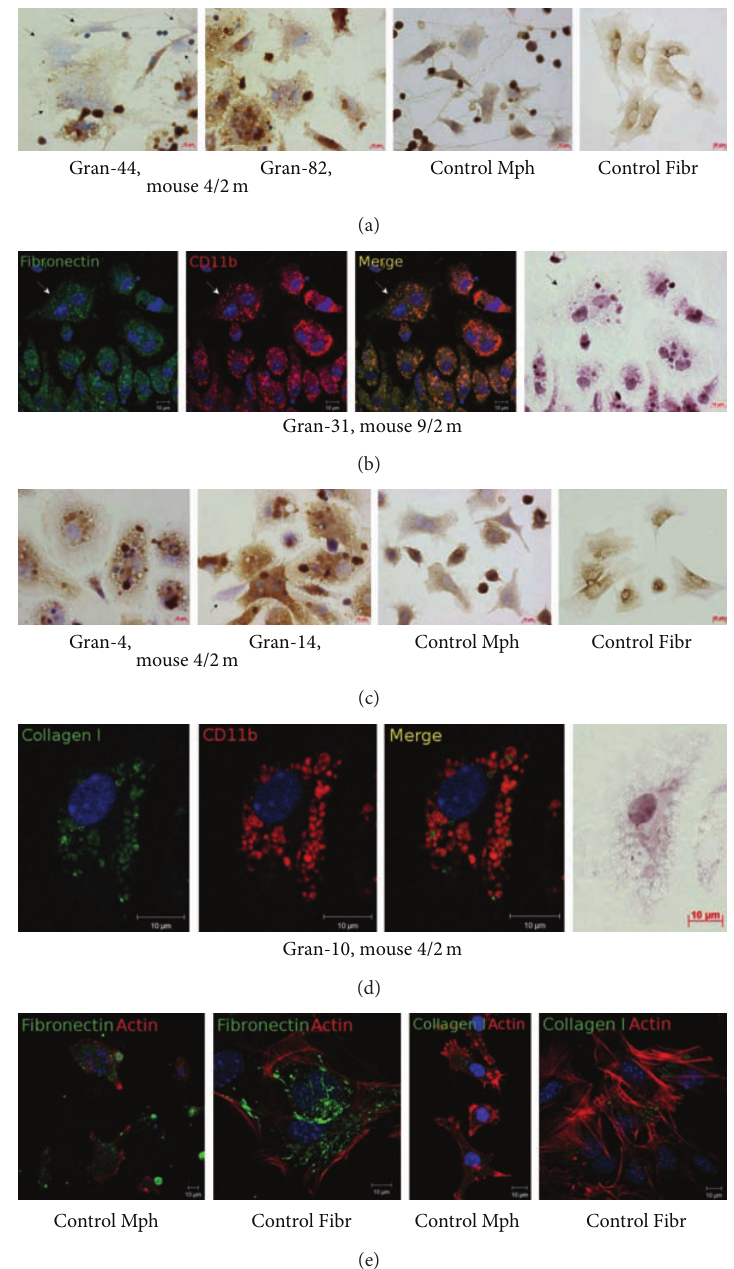
Figure 12: Fibronectin and type I collagen (collagen I) in the cells in the fragments of mouse splenic granulomas. The scale bars are ((a, right panel), (c, right panel)) 20 𝜇 m each and ((a)–(e)) 10 𝜇 m each. ((b), (d)-(e)) Colocalization of the markers on confocal images of cells (yellow signal). Nuclei stained by DAPI (blue signal). ((a), (c)) Immunochemical localization of (a) fibronectin and (c) type I collagen in granuloma cells and control mouse peritoneal macrophages (Mph) and splenic fibroblasts (Fibr). The brown color indicates the presence of the markers in these cells. The black arrows indicate fibroblasts; the other cells are macrophages, dendritic cells, and lymphocytes. (b) Confocal immunofluorescent localization of fibronectin (green signal) and CD11b (red signal) in granuloma macrophages. In the right panel, the same fragment as in the other panels restained for acid-fast BCG-mycobacteria by the ZN method. A macrophage with BCG- mycobacteria reproducing in it is indicated by the white arrows on the fluorescent images and the black arrow on the ZN image. (d) Confocal immunofluorescent localization of type I collagen (green signal) and CD11b (red signal) in a granuloma macrophage with BCG-mycobacteria. In the right panel, the same fragment as in the other panels restained for acid-fast BCG-mycobacteria by the ZN method. (e) Confocal immunofluorescent localization of fibronectin (green signal), type I collagen (green signal), and filamentous actin (red signal) in the control peritoneal macrophages and fibroblasts. Abbreviations as in Figure